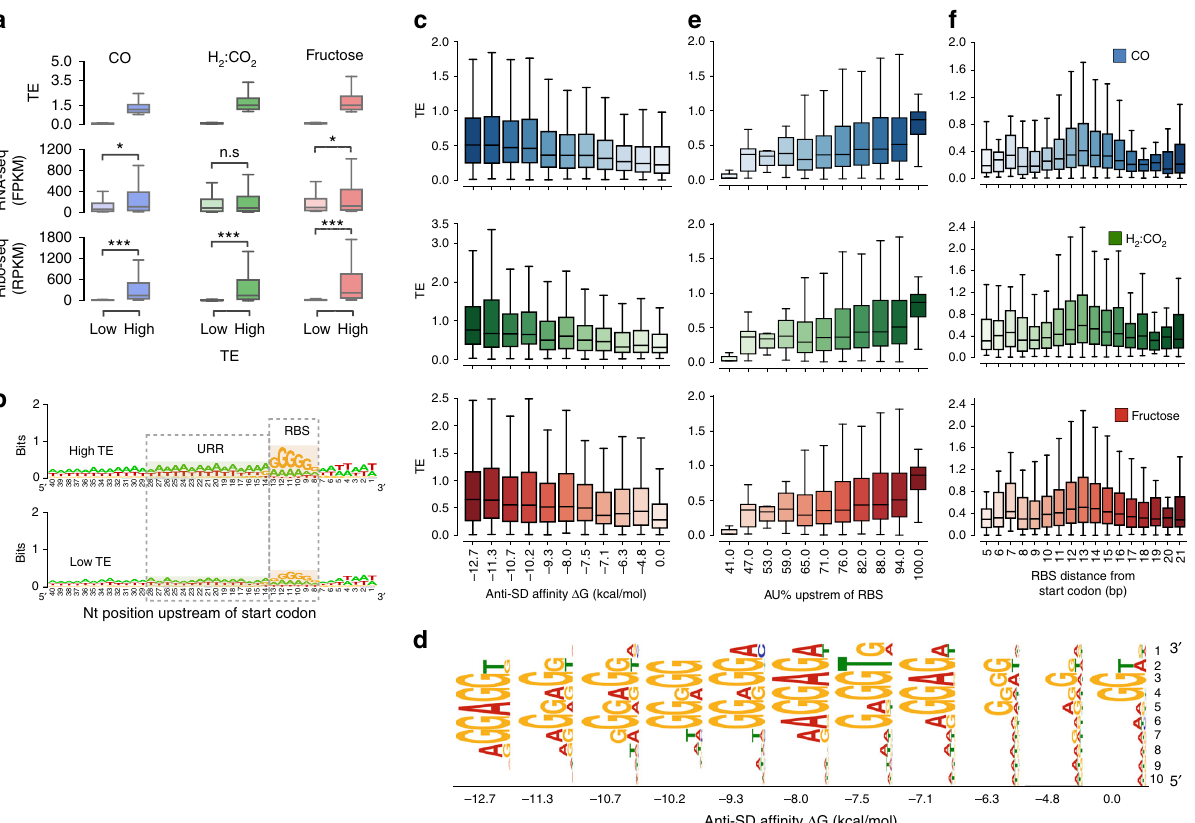
Fig. 5 In fl uence of 5´UTR features on TE. a Comparison between genes with low and high TE in all conditions. Low-TE genes are below 20th percentile, whereas high-TE genes are above 80th percentile in all conditions. P < 1e − 10 are signi fi ed with “ *** ” , 1e − 10 ≤ P < 0.01 are signi fi ed with “ * ” and P ≥ 0.01 are signi fi ed with “ n.s ” . b Low- and high-TE genes in all conditions have visible differences in their RBS sequence and the AU content in their upper RBS region (URR). The RBS and the URR regions are both highlighted with dotted gray boxes. c RBS af fi nity towards the anti-Shine Dalgarno (aSD) sequence (AAGGAGGU) positively affects TE in all conditions. The af fi nities of RBS towards the aSD region were categorized into 11 groups ranging from Δ G of 0 to − 12.7. d The RBS motif per each category in CO was determined using MEME. e Positive effect of the 15 bp AU% content in the URR on TE in all conditions. TSS data were used to ensure that TSS is upstream of the URR. f The distance of the RBS 5 ′ end from the start codon is most optimum at 13 bp. Deviation